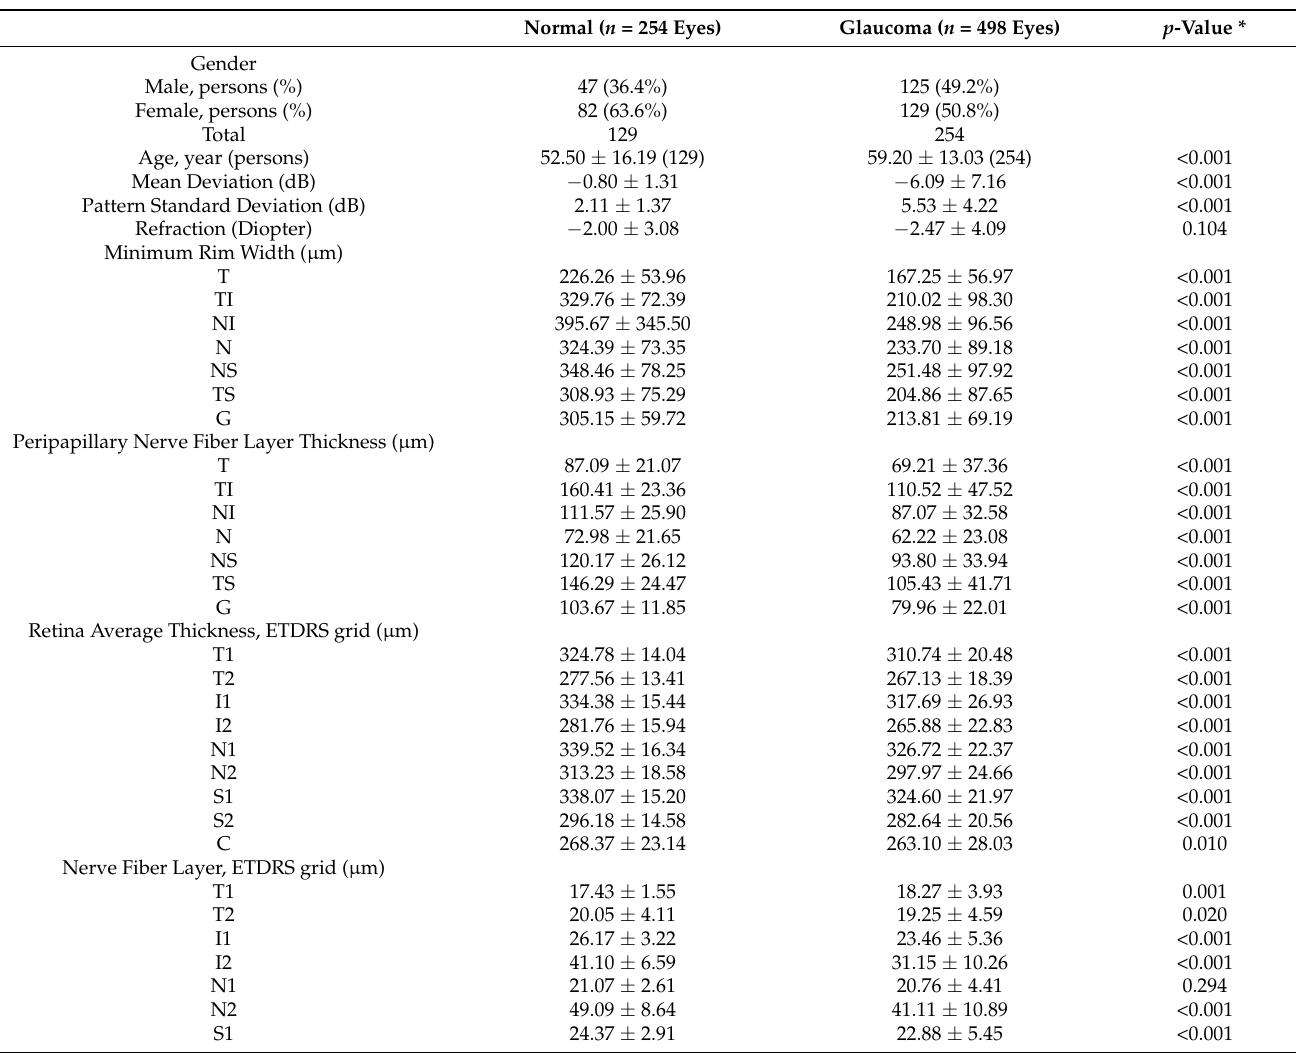
Table 2. The demographic and clinical characteristics of the study